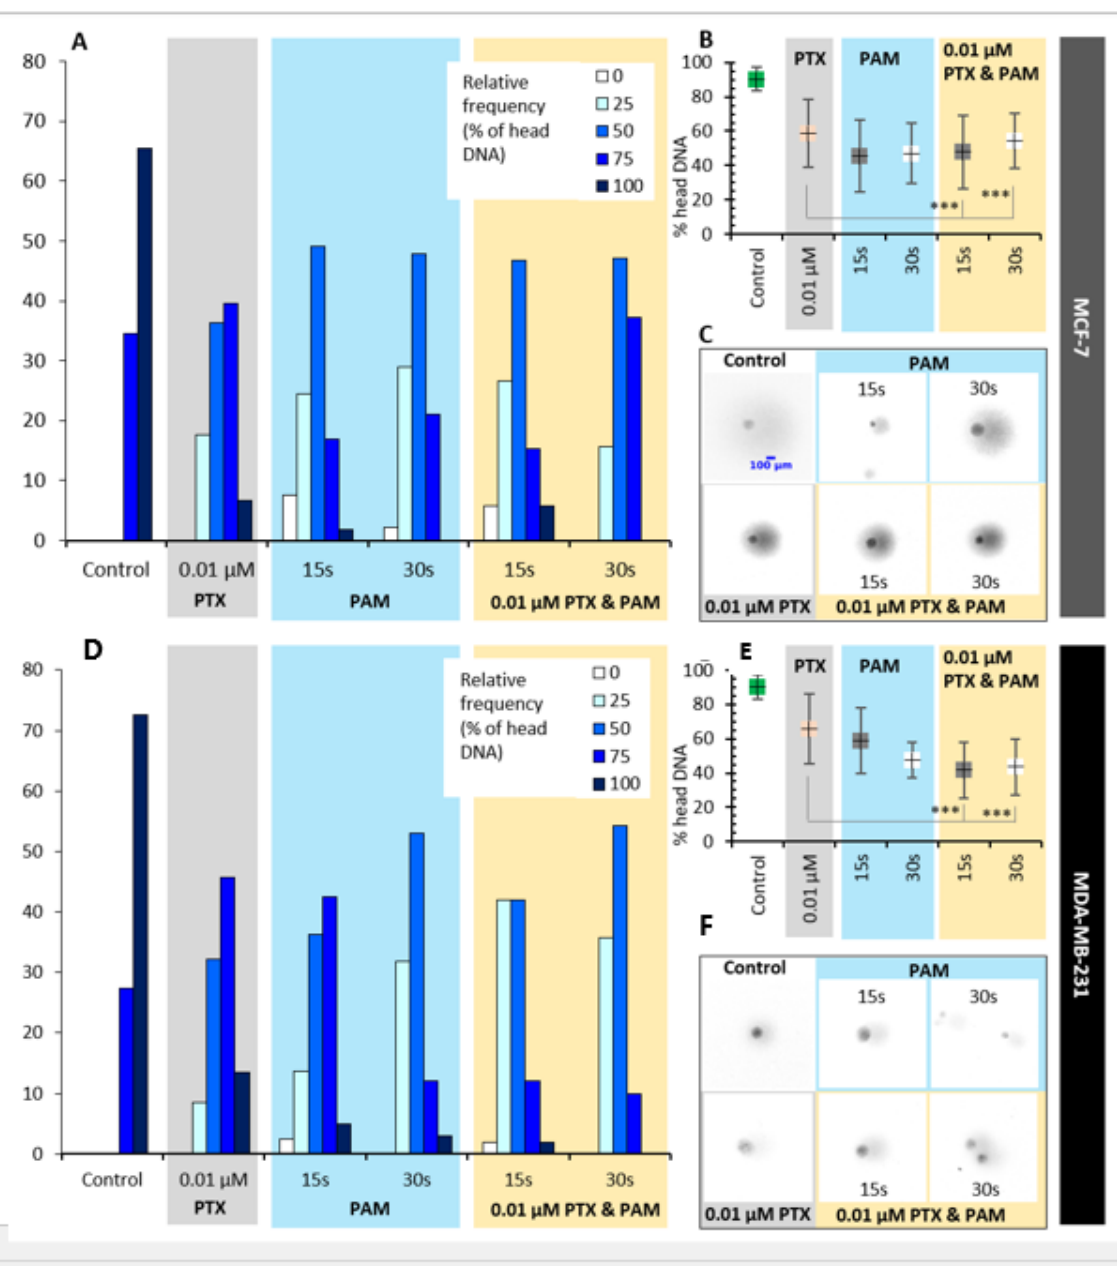
Figure 7. Evaluation of genotoxicity in MCF-7 and MDA-MB-231 cells. ( A , D ) Relative frequency of DNA content in experimental groups; ( B , E ) content of DNA (%) COMET head; ( C , F ) and characteristic microscopic photos of comets, indicating the genotoxic impact of the treatment applied with PTX, PAM, or combined treatment. Data are mean and SEM values ( n = 3). One-way analysis of variance followed by the Tukey post hoc test was applied in order to evaluate the statistical